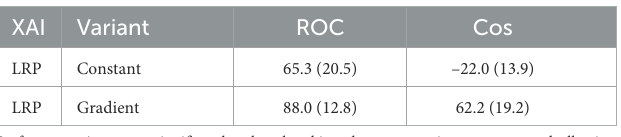
TABLE 5 Results of LRP on the ERP autoencoder when keeping the distance layer input constant as in Kauffmann et al. (2020b) and when allowing a gradient